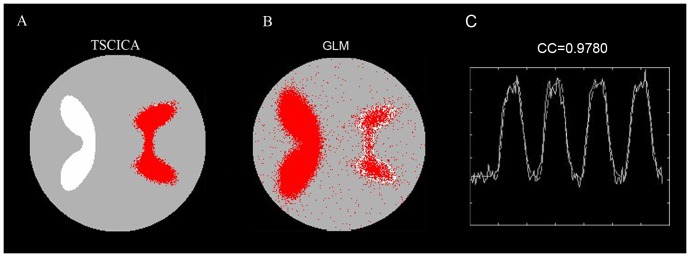
Results of the comparison of TSCICA and GLM.(A) The spatial activation map of the target component that was extracted by TSCICA. (B) The spatial activation that was detected by GLM. (C) The temporal reference (dotted line) and the time course (solid line) that correspond to the target component that was extracted by TSCICA. CC is the correlation coefficient between the estimated time course and the temporal reference.